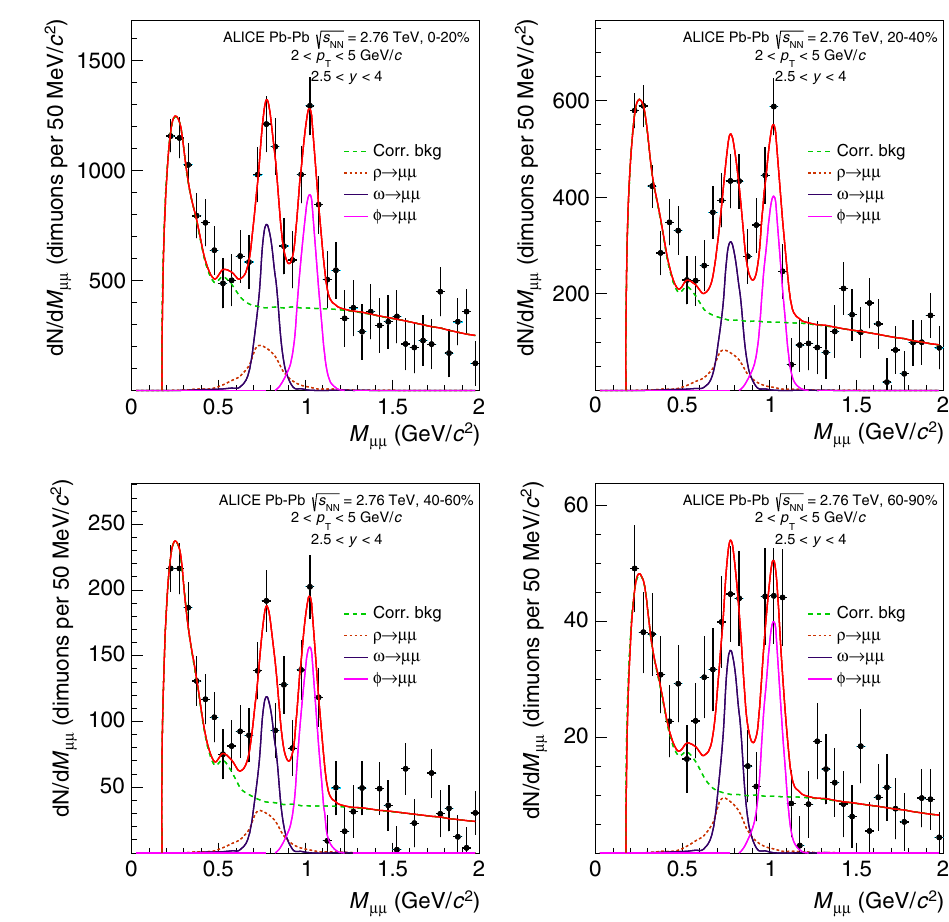
Fig. 3 Invariant mass spectra in different centrality classes for 2 < p T < 5 GeV/c in Pb–Pb √ s NN = 2 . 76 TeV. collisions at The solid red line represents the result of the fit to the hadronic cocktail; the green dashed line represents the correlated background, given by the sum of all the MC sources other than φ , ρ and ω